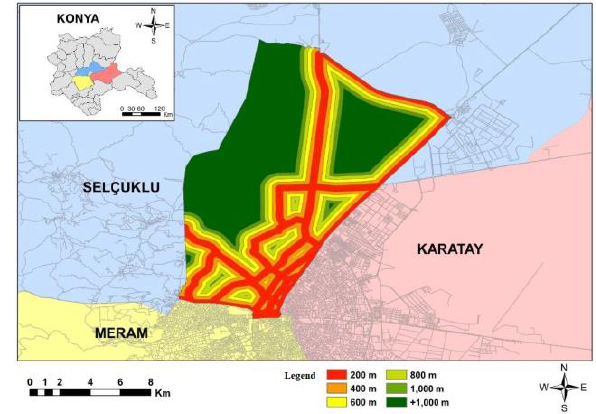
Figure 9. Main roads density